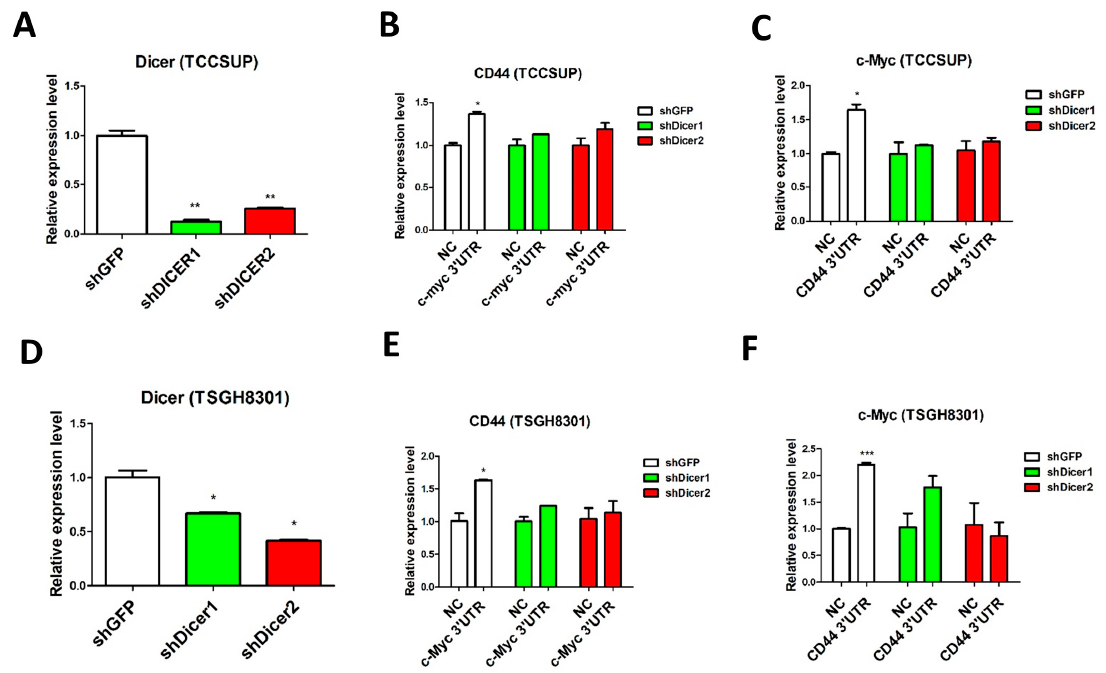
Figure 5. Dicer knockdown diminishes the ceRNA effects of c-Myc and CD44 in urothelial carcinoma cells. Dicer was depleted by shRNA in TCCSUP and TSGH8301 urothelial carcinoma cells. Relative expression of Dicer was assessed in ( A ) TCCSUP and ( D ) TSGH8301 cells using RT-PCR. Expression of CD44 ( B , E ) and c-Myc ( C , F ) in the control and Dicer-depleted cells was also assessed using RT-PCR. (* p < 0.05; ** p < 0.01, *** p < 0.001).